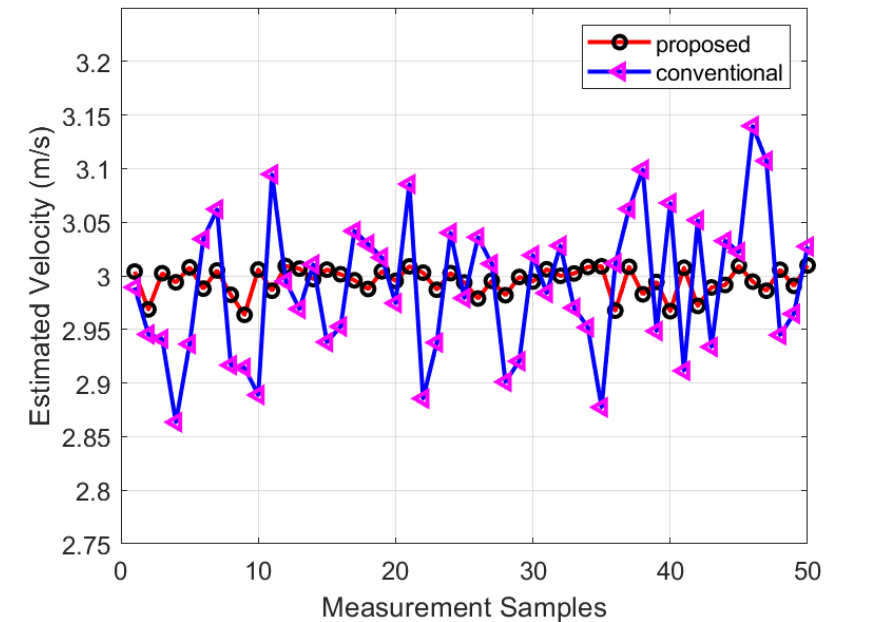
Figure 6. Comparison of current velocity estimation results of 50 measurement samples of two transmitted signals with SNR of 15